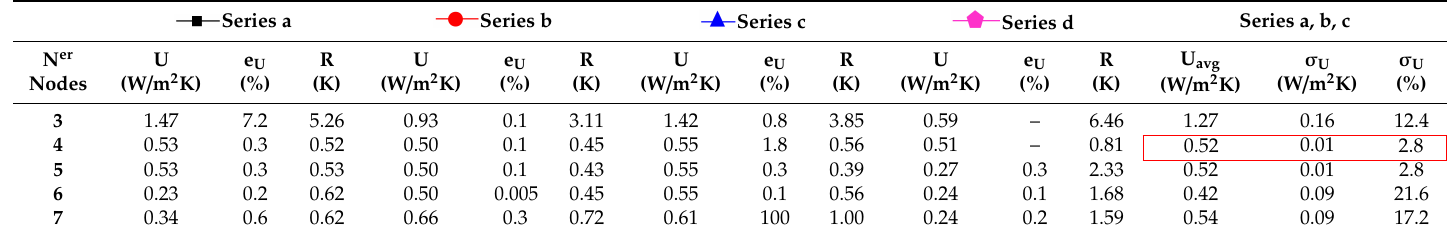
Table 2. Ceiling. U value. Summary of the results using models that do not include solar radiation. Output: T i . Where e U is the error and R is the average of the residuals given by LORD for each data series.